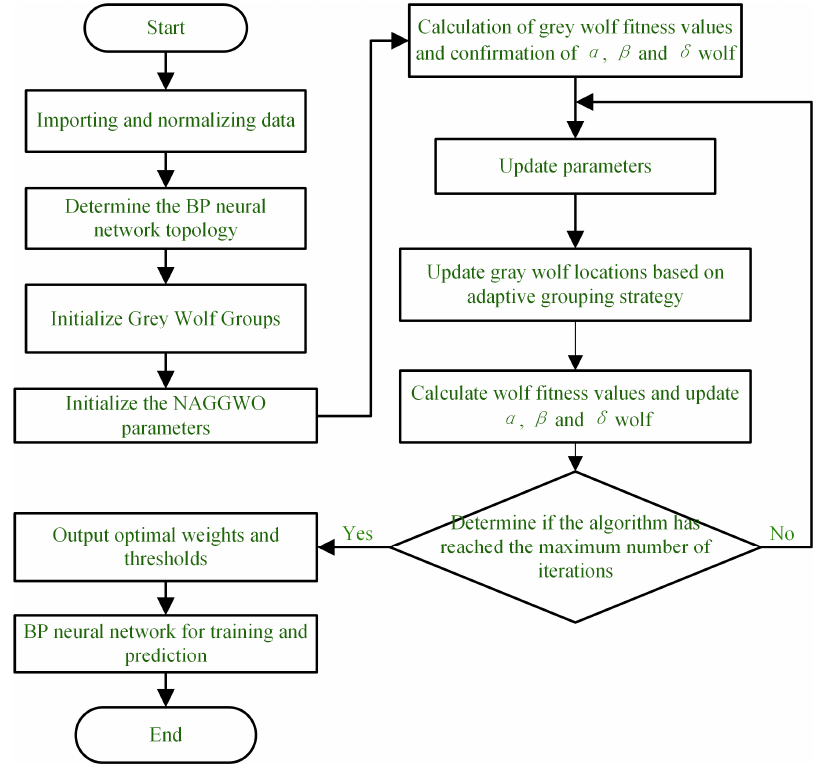
Figure 4. Flowchart of NAGGWO-BP algorithm.